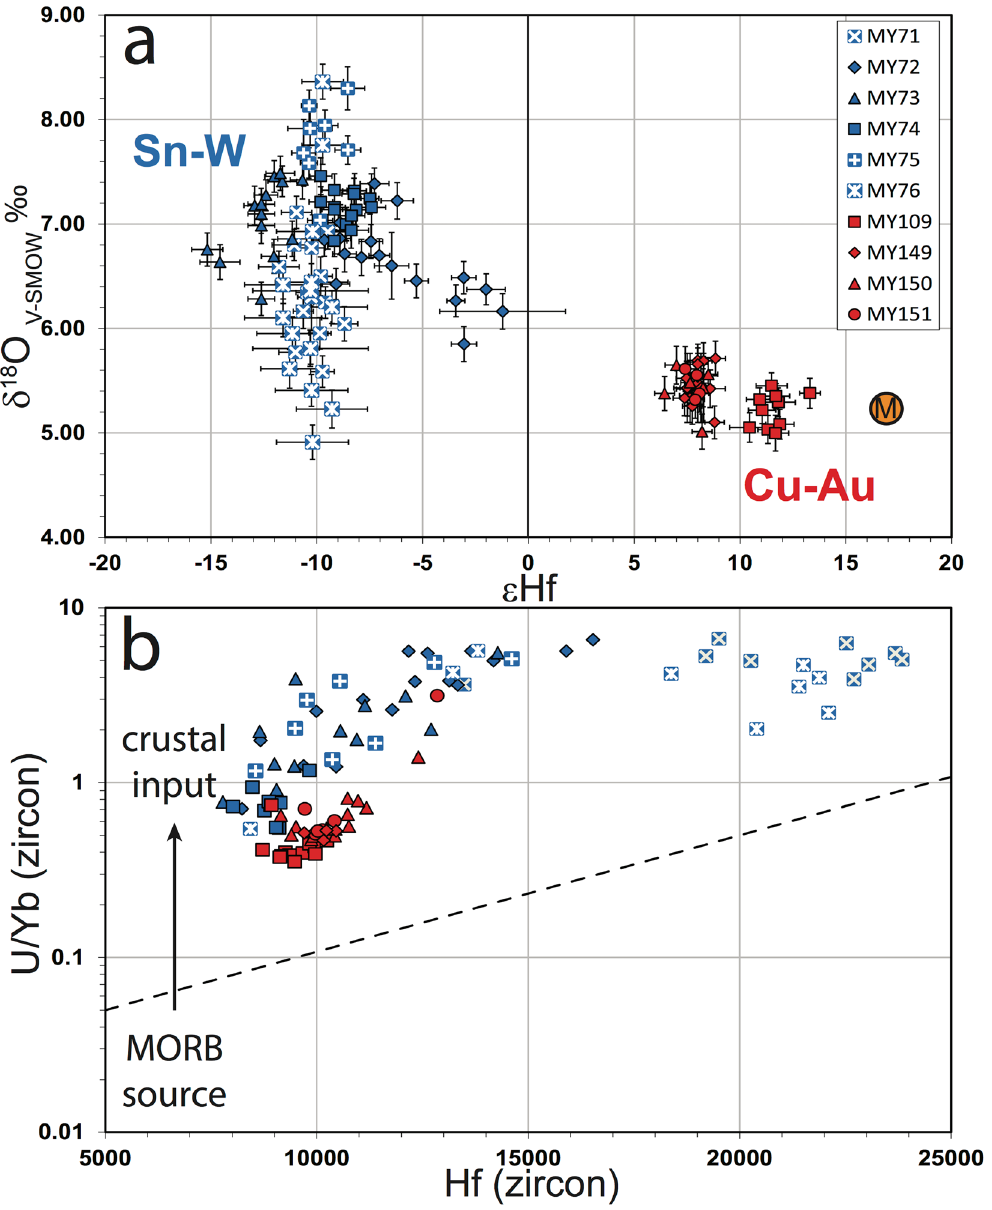
Figure 2. Zircon isotope and trace element plots highlighting source, plotted by sample and suite. Samples MY71, MY75 and MY76 have a high ( > 15 ppm) Sn content (white crosses). (a) Initial ε Hf versus δ 18 O; error bars 2 σ M is a representative mantle value. ( b ) U/Yb versus Hf 5